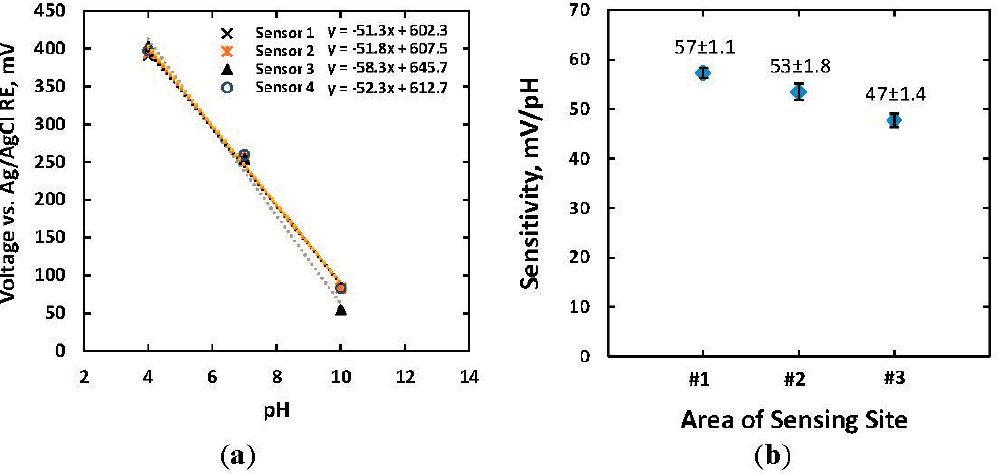
Figure 4. ( a ) The pH sensitivity of four IrO x -based electrodes with an electrode size